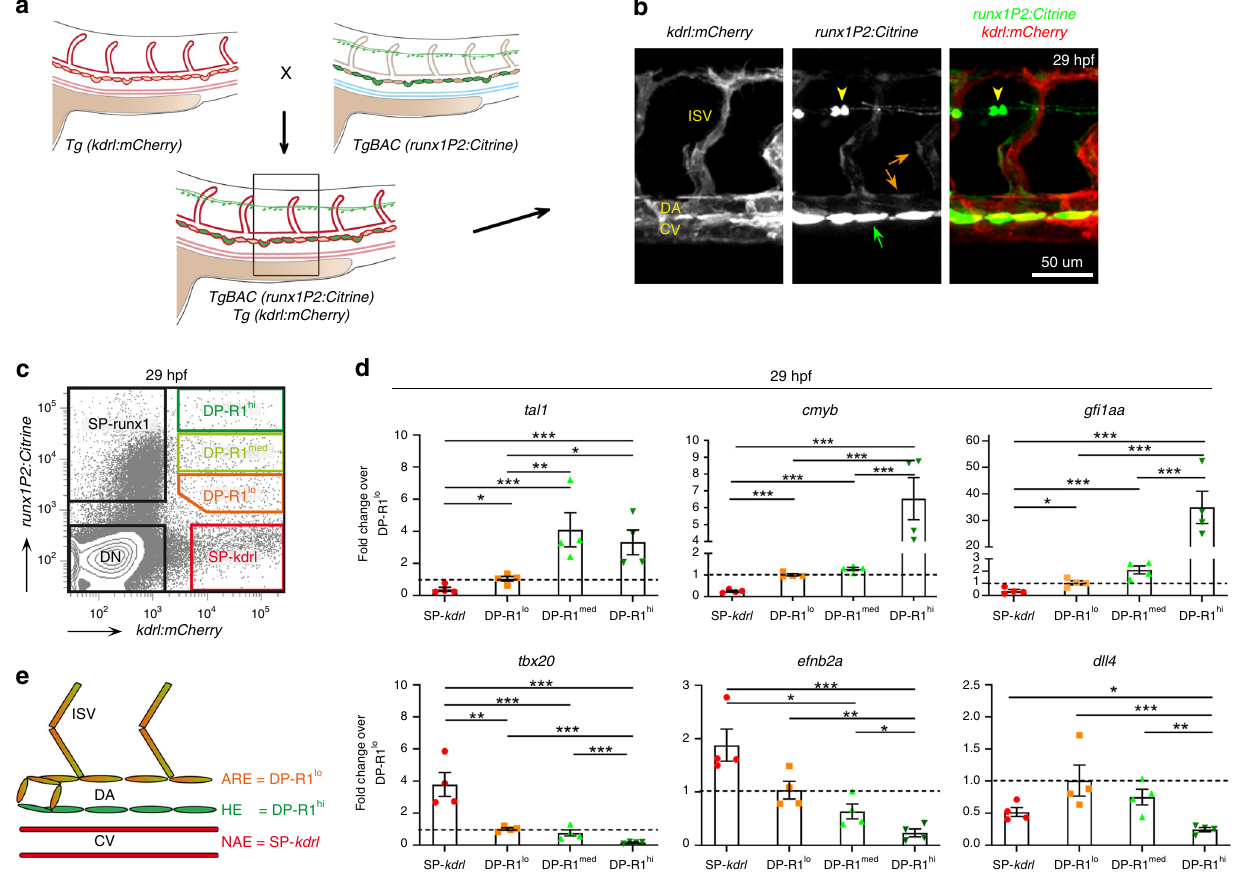
Fig. 2 FACS based isolation of haemogenic and aortic roof endothelium. a Schematic of transgene expression in the trunk region of double transgenic TgBAC(runx1P2:Citrine);Tg(kdrl:mCherry) embryos during de fi nitive haematopoiesis. b Representative confocal image of the DA region of double transgenic TgBAC(runx1P2:Citrine);Tg(kdrl:mCherry) embryos at 29 hpf. Laser intensities enhanced to detect Citrine fl uorescence in the DA roof and sprouting inter- somitic vessels (ISV) (orange arrows) in addition to the HE (green arrow). Yellow arrow heads: neurons in the spinal cord. c Characteristic FACS plot of the established gating strategy for the isolation of endothelial sub-populations ( runx1 hi kdrl + [DP-R1 hi ]; runx1 med kdrl + [DP-R1 med ]; runx1 lo kdrl + [DP-R1 lo ]; runx1 − kdrl + [SP- kdrl ]) from double transgenic TgBAC(runx1P2:Citrine);Tg(kdrl:mCherry) embryos. d qRT-PCR analysis of haematopoietic ( tal1 , cmyb and g fi 1aa ) and endothelial ( tbx20 , efnb2a and dll4 ) marker gene expression in the different cell fractions isolated from ~29 hpf embryos following the FACS gating strategy depicted in ( c ). Graphs show the measured mean fold change relative to the expression detected in the DP-R1 lo fraction. n = 4 independent experiments. Error bars represent the SEM. 1-way ANOVA; * p < 0.05; ** p < 0.01; *** p < 0.001. e Schematic of the vessel structure in the zebra fi sh trunk region discriminating between aortic roof endothelium (ARE) including the ISV, the HE and the non-aortic endothelium (NAE) including but not restricted to endothelial cells from the cardinal vein (CV). The depicted colour code refers to the colours of the FACS gates presented in ( c